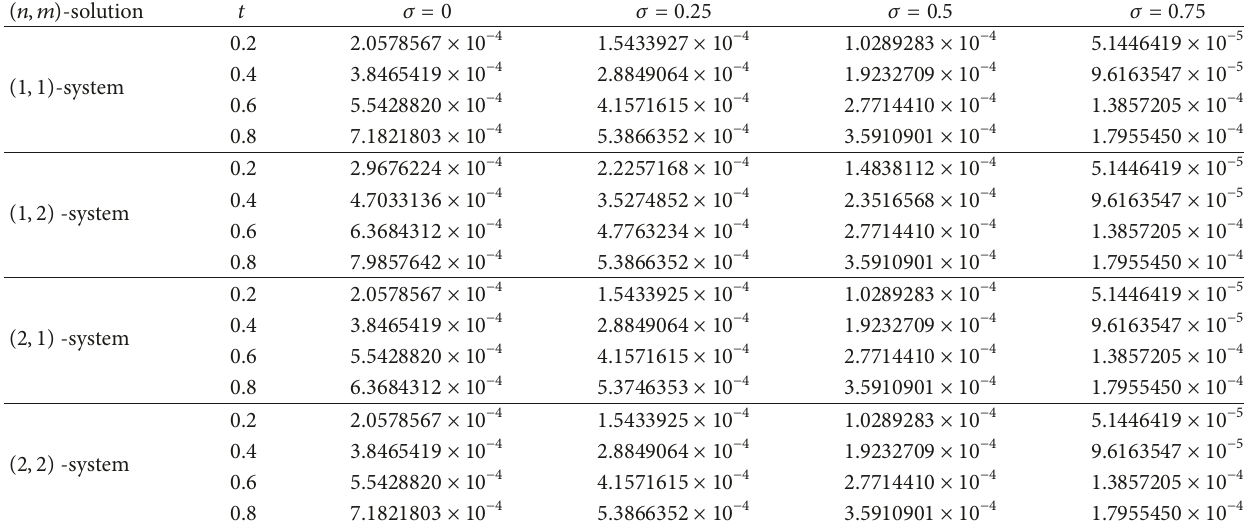
Table 1: The absolute error of 10 th approximation of FFIVPs (30) and